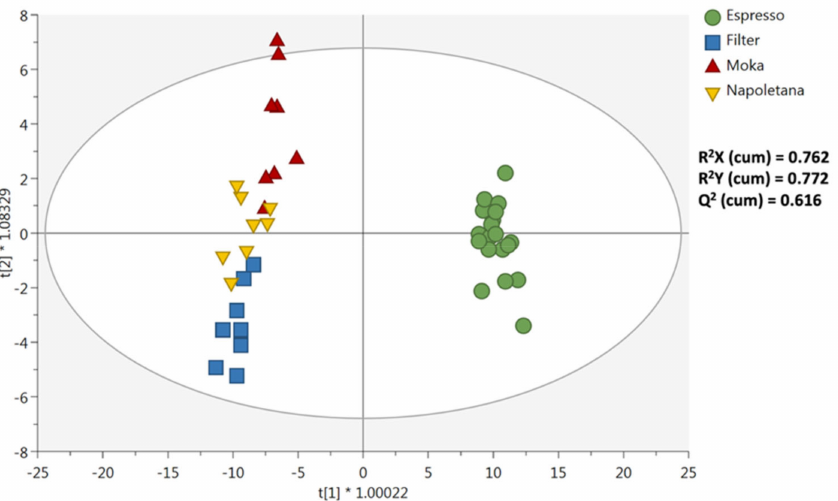
Figure 3. Orthogonal Projections to Latent Structures Discriminant Analysis (OPLS-DA) score plot for the different coffee samples included in the different extraction category (i.e., Espresso, Filter, Moka, and